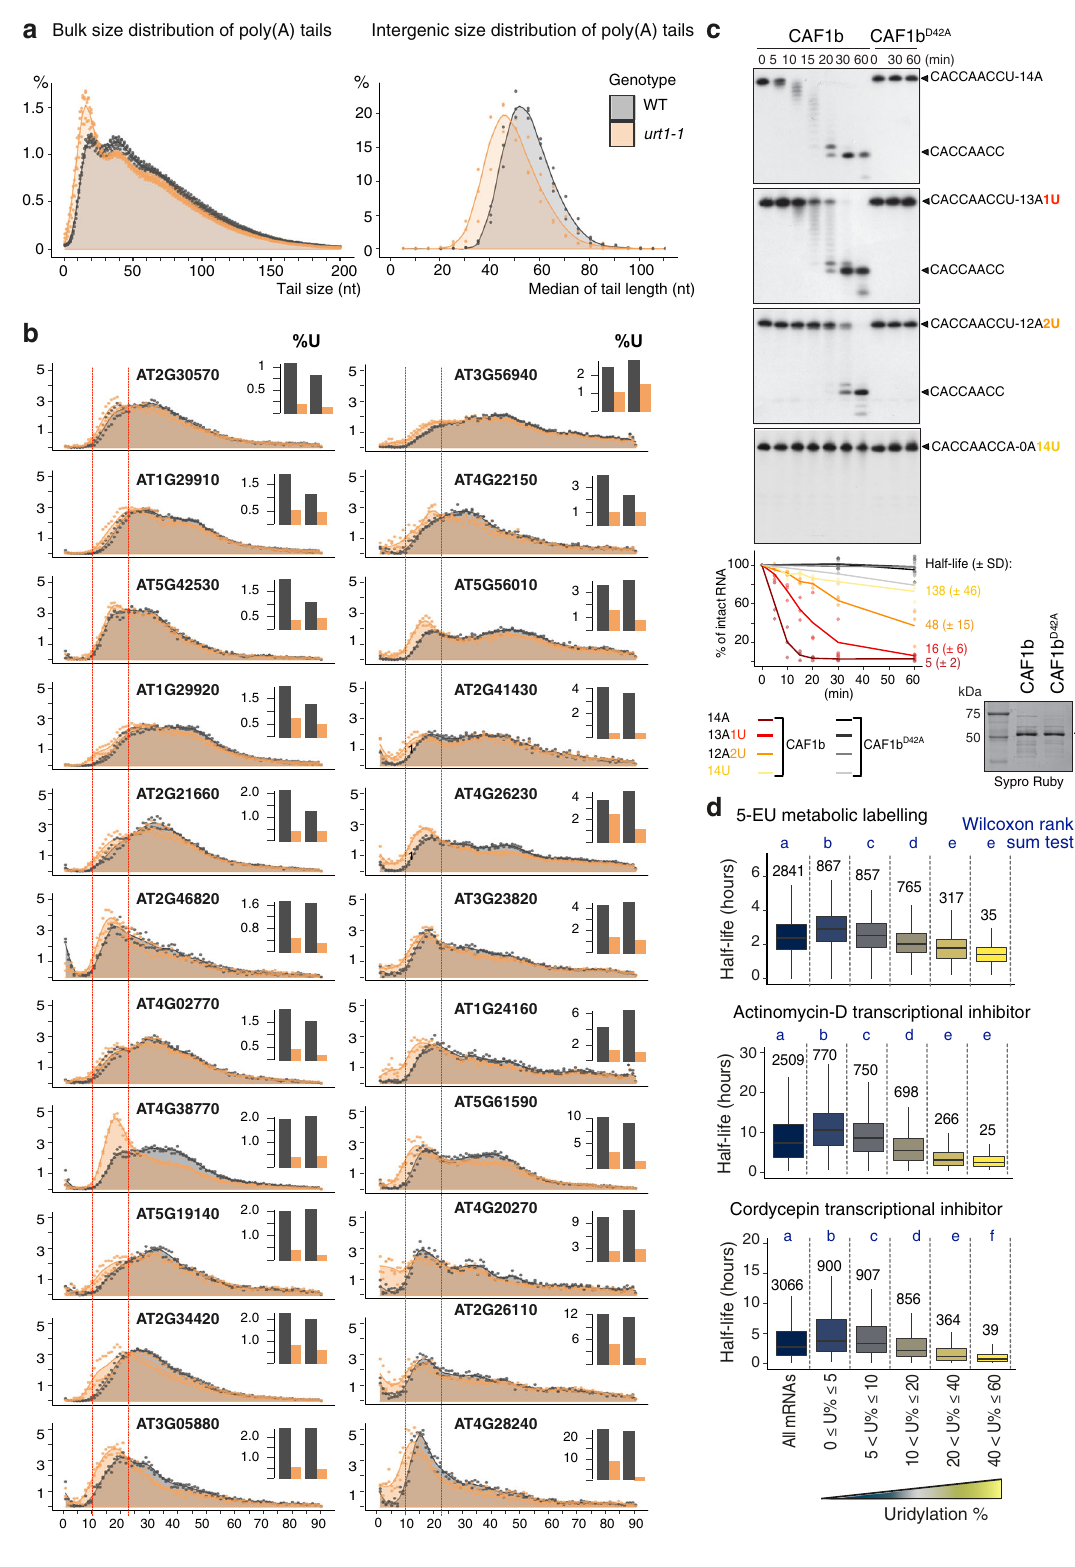
fi rst and last genes shown in Fig. 5b, respectively). In agreement with our previous studies 11,12 , mRNA uridylation levels drop in urt1 mutants (bar plots in Fig. 5b), and uridylation tags mostly oligoadenylated mRNAs, i.e., mRNAs with tails of <25As